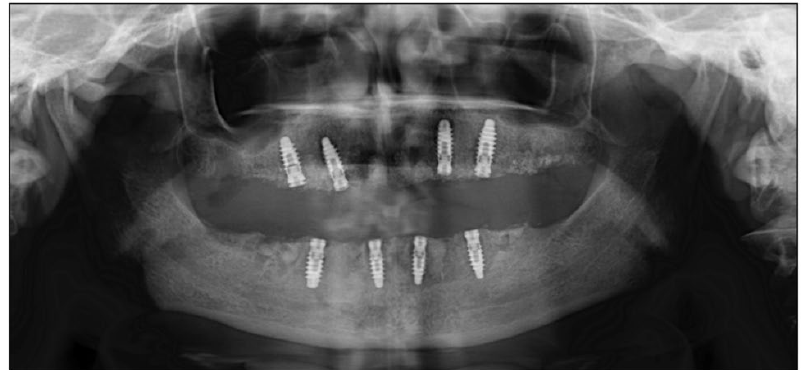
Figure 6. Postoperative (5 days after surgery) panoramic radiographs.